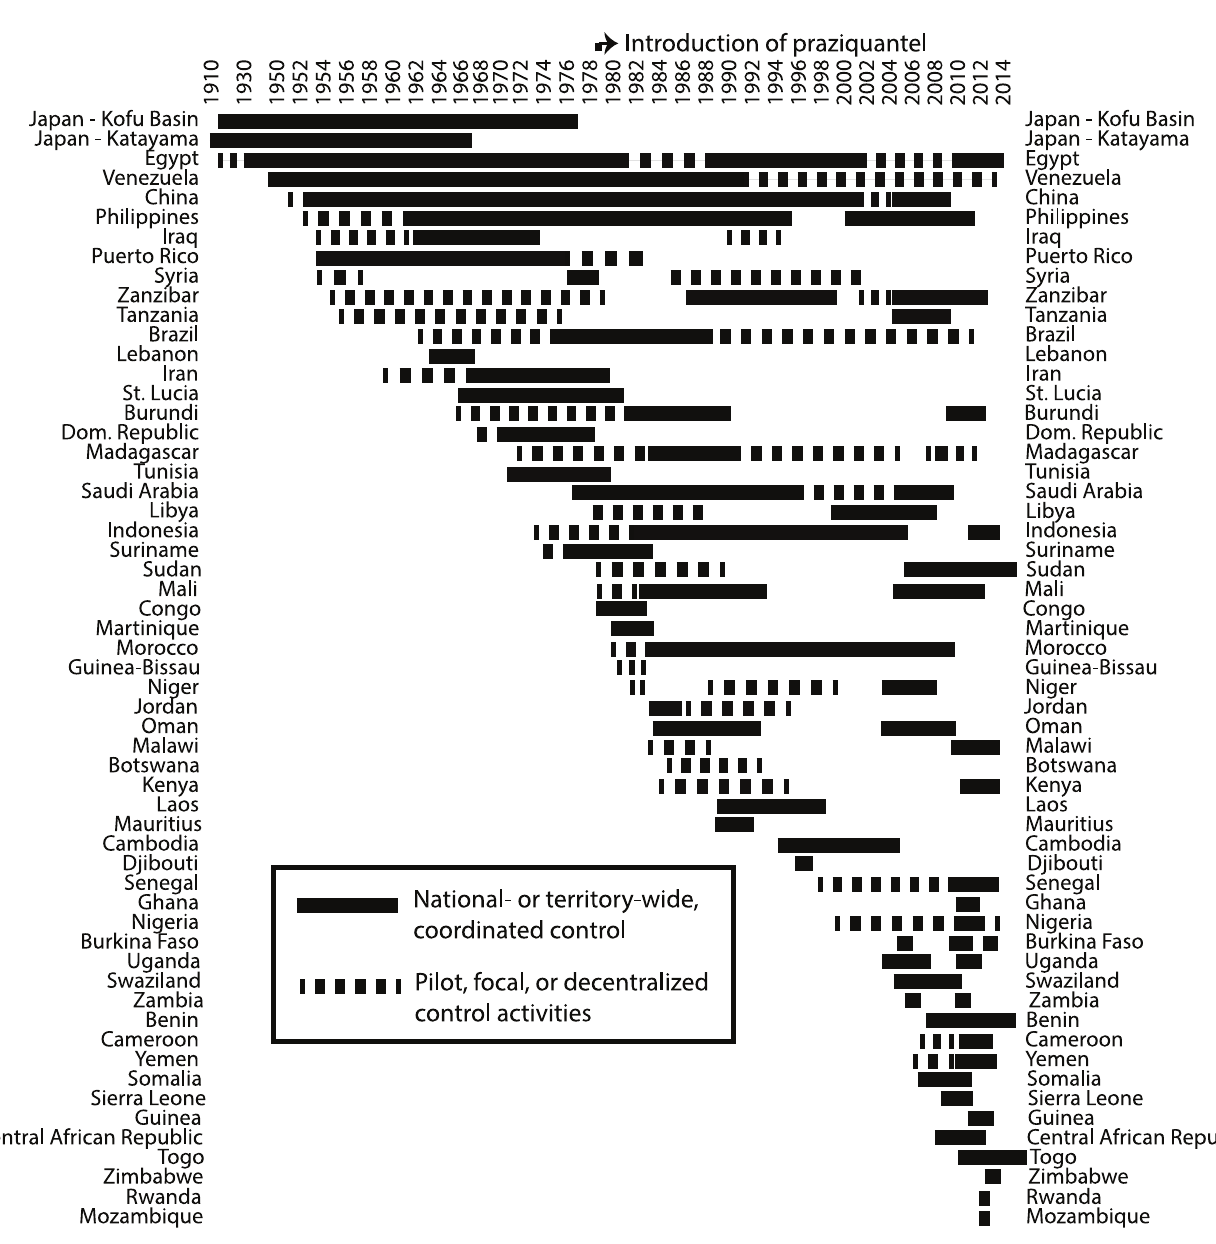
Fig 4. Schistosomiasis control programs over time. See Fig 5 for more details on control strategies and outcomes. Tunisia — applied coordinated control programs and achieved “ success ” as we defined it here. Nine countries/territories that have not yet achieved schistosomiasis elimination achieved a 90% or greater reduction in their country-level prevalence since baseline (before control): The remaining countries had variable schistosomiasis prevalence over the past century (Table 1), depending, in part, on their control strategy.